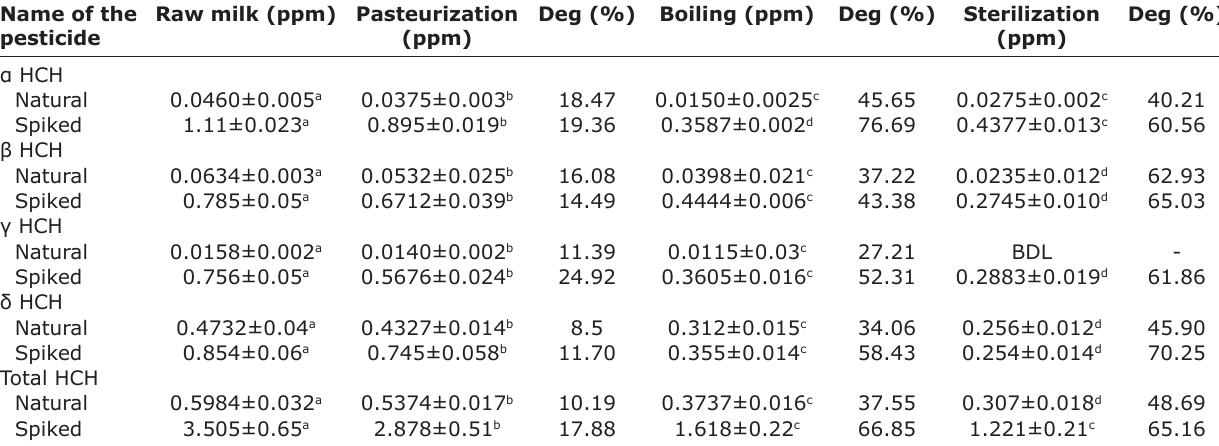
Table-2: Residual levels of organochlorine compounds after heat processing in milk. Name of the Raw milk (ppm) Pasteurization Deg (%) Boiling (ppm) Deg (%) Sterilization pesticide (ppm)